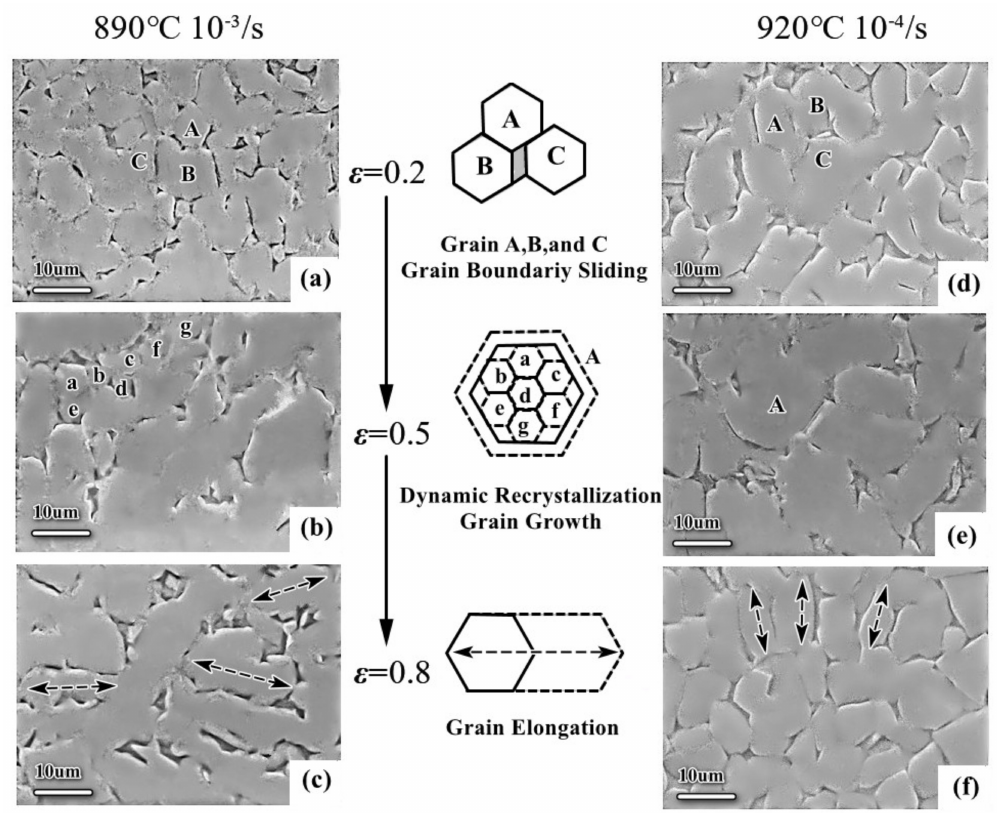
Figure 5. SEM observations for the Ti-6Al-4V alloy. ( a ) 890 ◦ C, 10 − 3 /s, ε = 0.2; ( b ) 890 ◦ C, 10 − 3 /s, ε = 0.5; ( c ) 890 ◦ C, 10 − 3 /s, ε = 0.8; ( d ) 920 ◦ C, 10 − 4 /s, ε = 0.2; ( e ) 920 ◦ C, 10 − 4 /s, ε = 0.5; ( f ) 920 ◦ C, 10 − 4 /s, ε =